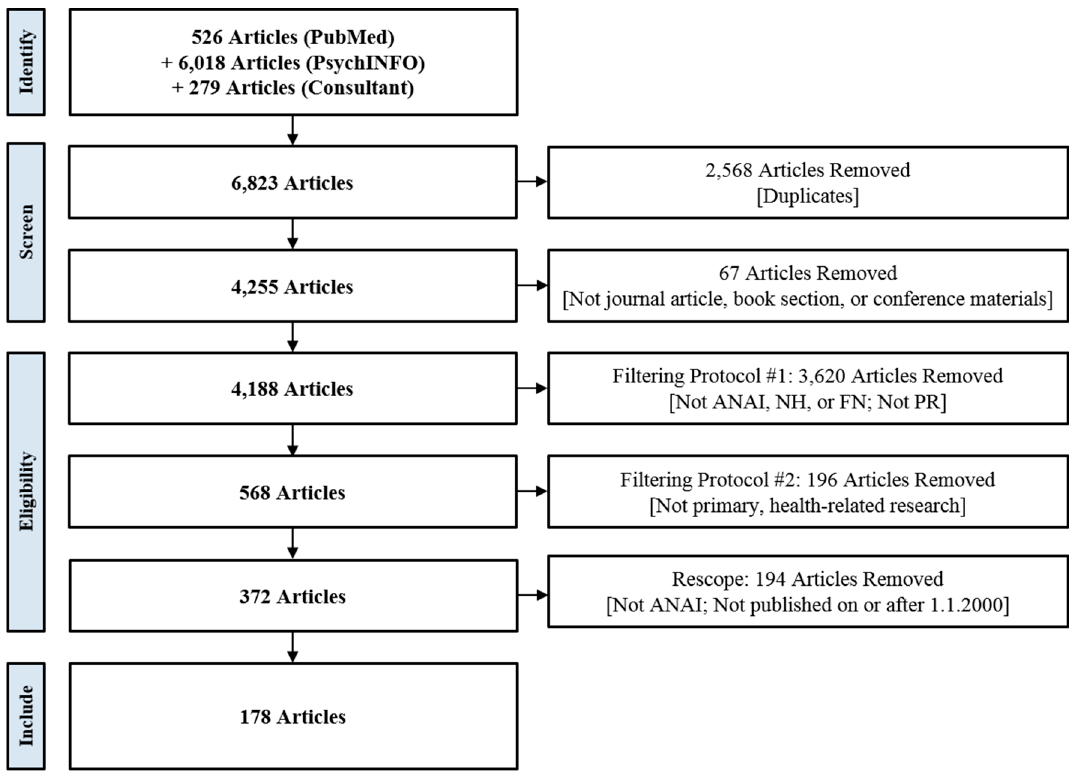
Figure 1. Article Selection Flow Chart.